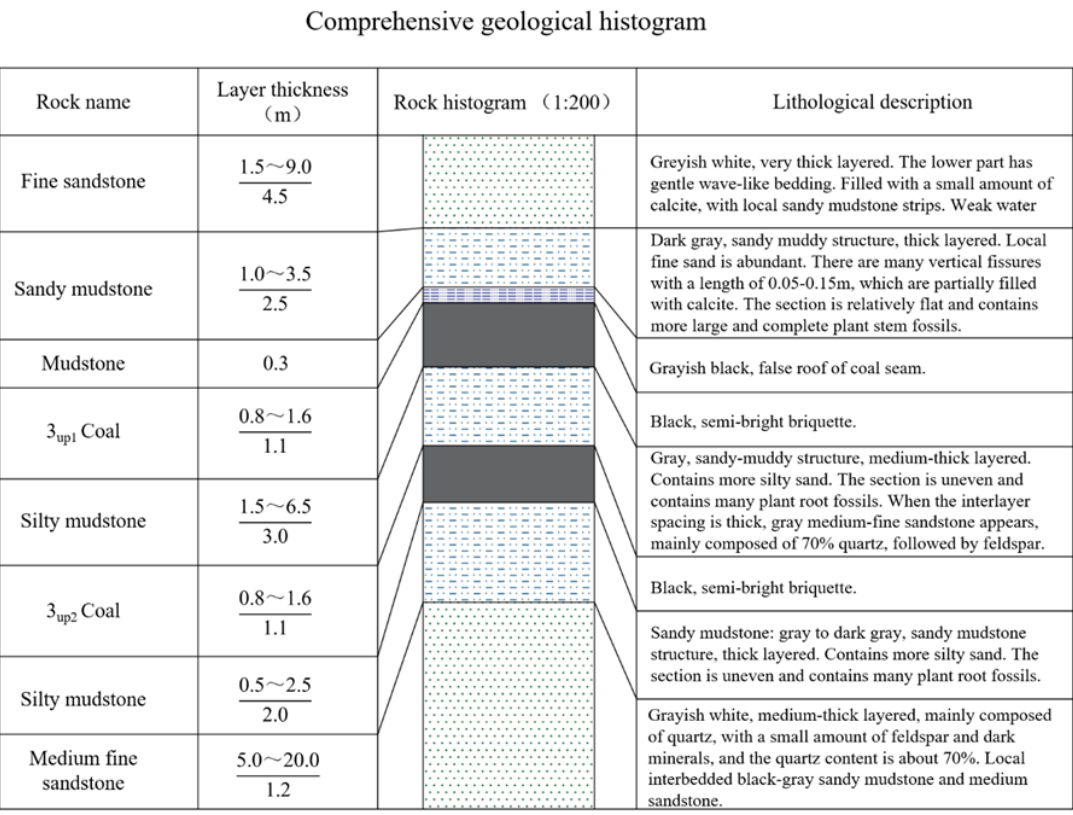
Figure 4. Plane layout of the 1510 working face.